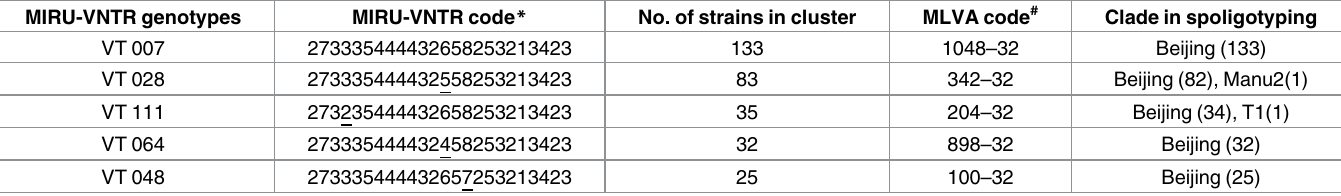
Table 1. Five most prevalent genotypes with more than 20 strains in each genotype